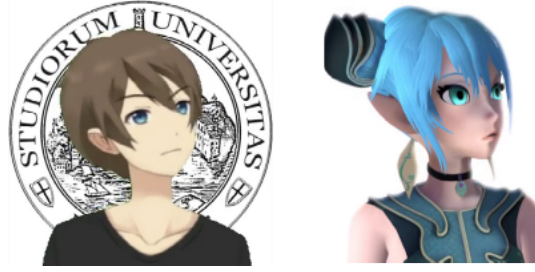
Figure 7. MICA characters support deictic visual cues.